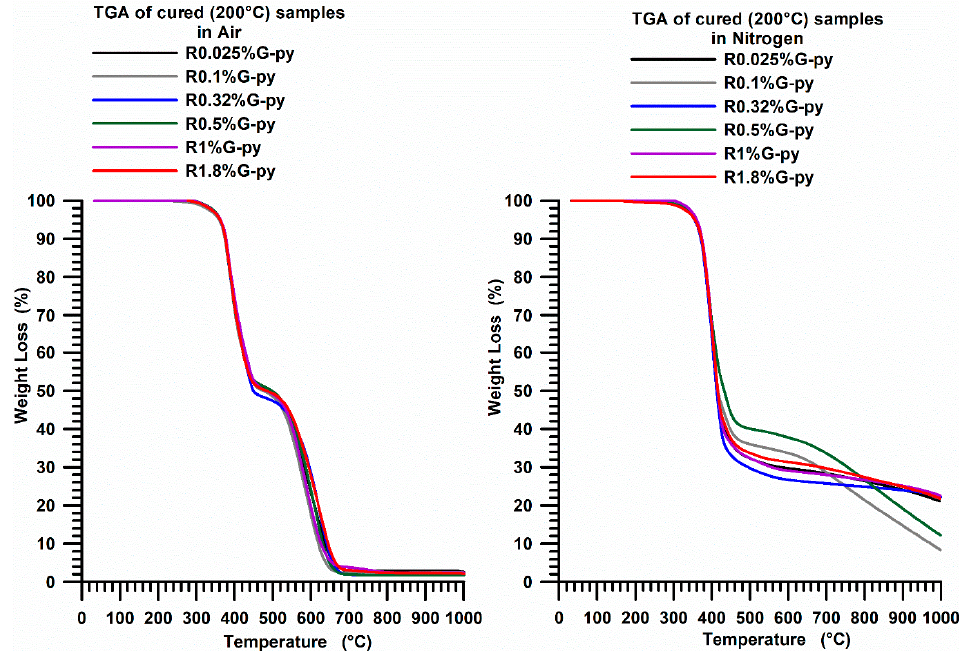
Figure 17. TGA curves in air and in nitrogen of the G-py based nanocomposites cured up to 200°C.